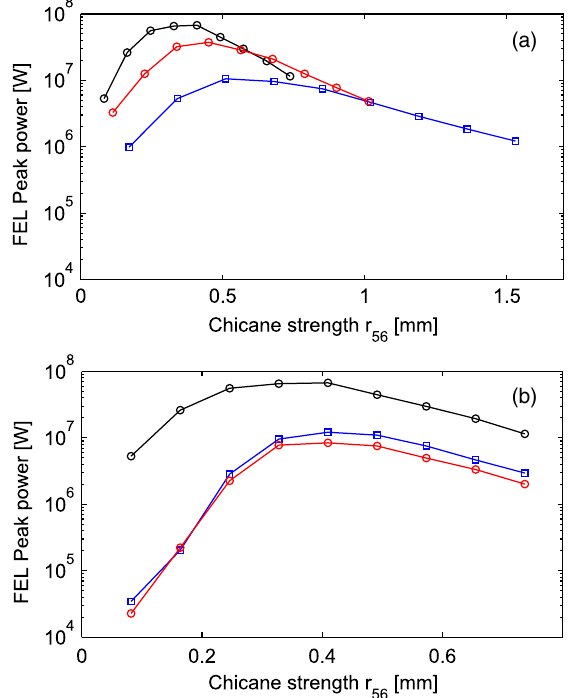
FIG. 6. FEL peak power at 200 nm versus chicane strength. (a) Simulation without collective effects and with magnifications r 11 ¼ r 33 of (black circle) 10, (red square) 12 and (blue square) 15. (b) Simulation with r 11 ¼ r 33 ¼ 10 and (black) without collective effects, (blue) with the space charge and (red) with the space charge and the CSR. Beam transport simulation in the nonlinear case with BETA and sympletic 6D tracking using the S2I-CM optics. FEL simulation with GENESIS.